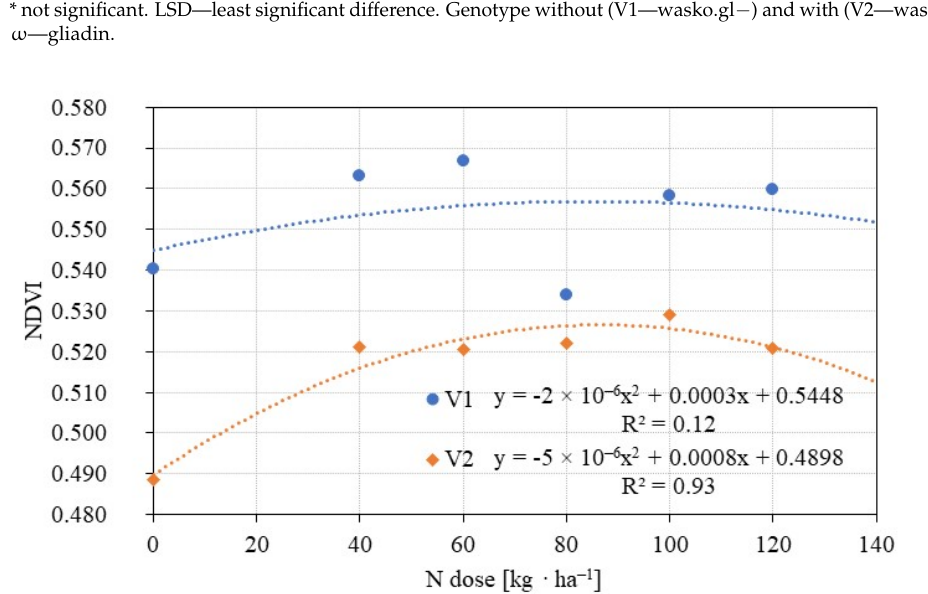
Figure 8. NDVI of winter wheat genotypes under N ‐ fertilization (22 May 2020)—BBCH 39. The LAI index was shaped according to the studied levels of sulfur and nitrogen fer ‐ tilization in the range of 3.32–4.99 for genotype V1 and 2.83–4.41 for genotype V2 (Figure 9). Only the genetic factor had a significant influence on the value of this index. There were very small insignificant differences between the levels of sulfur fertilization, while nitrogen fertilization had a positive effect on increasing the value of this index with doses of over 120 kg N ∙ ha − 1 for both genotypes. On average, within the range of 0–80 kg N ∙ ha − 1 , the increase in the LAI index was from 4.86 to 5.25 (Figure 9). Higher doses caused lodging of plants, as shown in the photos from the experiment site (Figure 3). The canopy chlorophyll content index (CCCI) index of the tested hypoallergenic wheat genotypes ranged from 0.572 to 0.646 for the V1 genotype and from 0.546 to 0.608 for the V2 genotype, respectively (Table 5). The differences between the cultivars were statistically insignificant but clearly marked. Sulfur fertilization did not significantly affect the value of this index. It seems that the optimal fertilization level is the dose of 20 kg S ∙ ha − 1 . Nevertheless, nitrogen fertilization did significantly influence the value of this